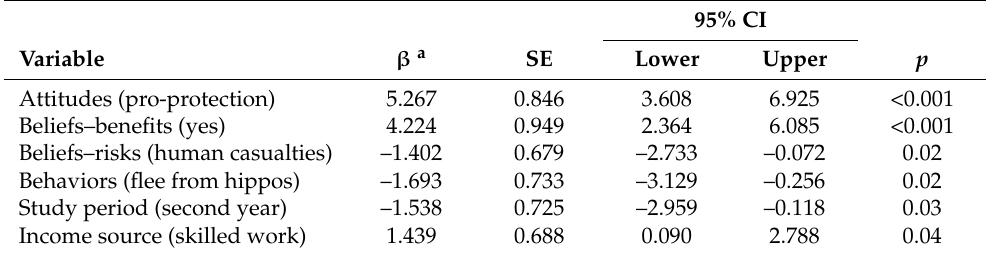
Table 4. Coefficients of predictors in the best model of acceptance of hippopotamus (AIC = 89.78).